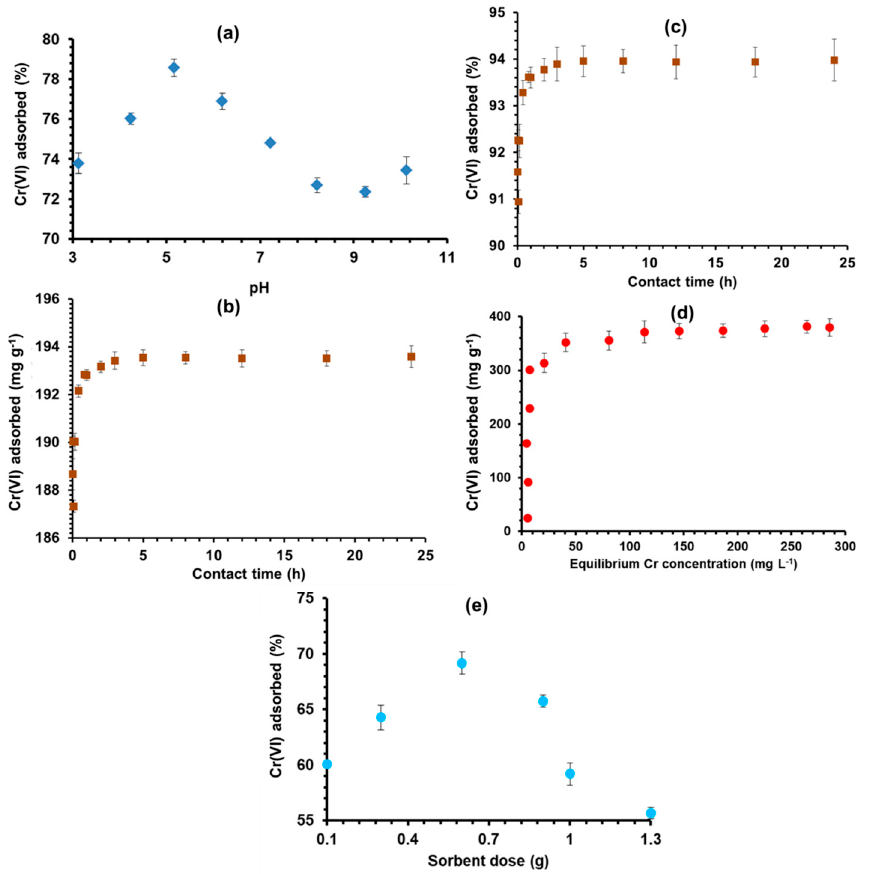
Figure 1. The Cr(VI) adsorption as a function of pH ( a ), contact time ( b , c ), initial Cr concentration ( d ) and sorbent dose ( e ) by rice husk from Cr(VI)-contaminated water.